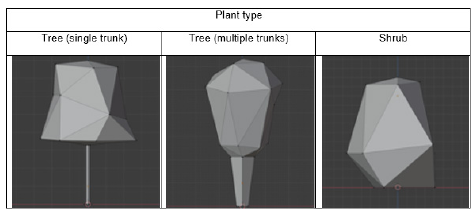
Figure 8. Various shapes and sizes based on spatial parameters